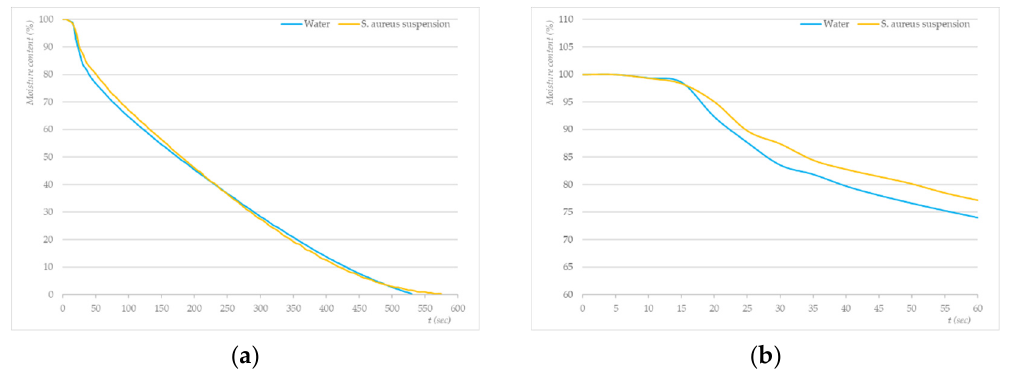
Figure 5. ( a ) Drying profiles of cotton swatches wetted with water (blue line) and swatches inocu- lated with a suspension of S. aureus ( N 0 = 3.67 × 10 7 CFU/mL, orange line) treated photothermally at 80 °C; ( b ) magnification of the first 60 s of the photothermal